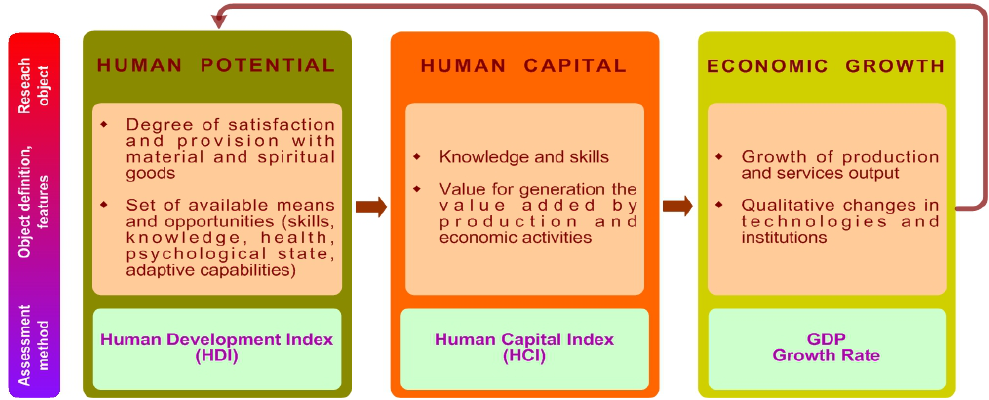
Figure 1. The relationship of physical (human) potential with human capital and economic growth under paradigm of United Nations Development Program (United Nations 2016; United Nations Development Programme 2019).